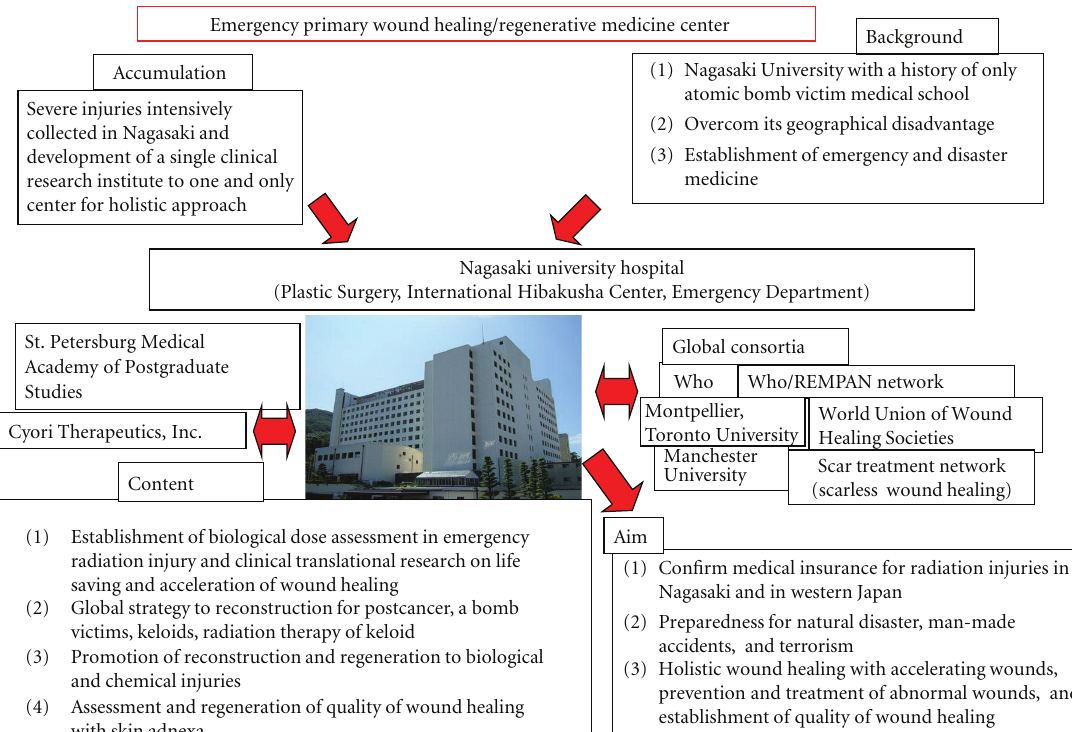
Figure 1: Strategy of emergency radiation injury. Collaborative work with highly established international centers and organ is proposed.